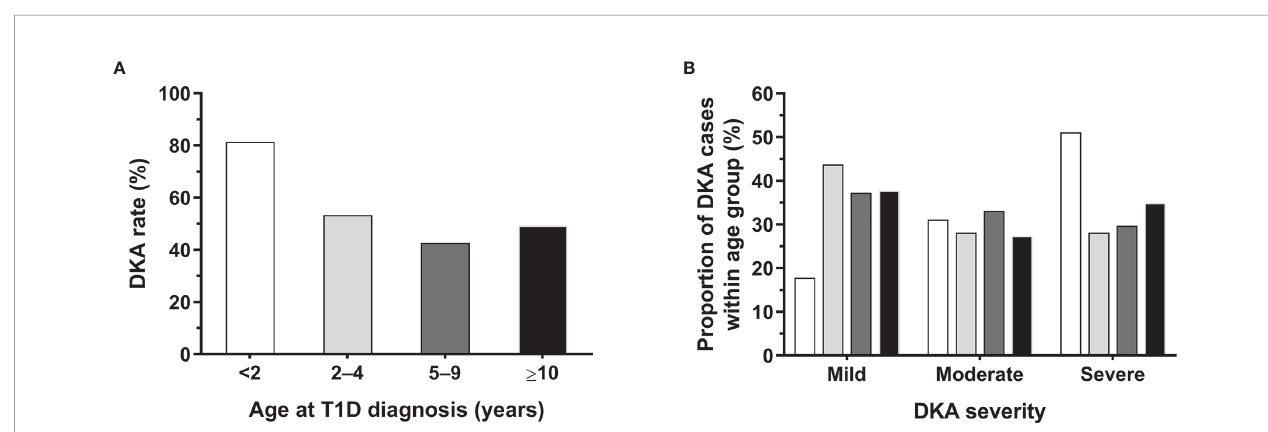
FIGURE 3 | Rates and severity of diabetic ketoacidosis (DKA) among patients aged <16 years newly diagnosed with type 1 diabetes (T1D) at the Children ’ s Hospital of Zhejiang University School of Medicine (Hangzhou, China), according to age group. (A) Percentage of patients with DKA according to age at diagnosis. (B) Proportion of cases according to DKA severity within age group, whose corresponding bars are color coded as per panel (A) ; the number of patients who had DKA at T1D diagnosis and data on its severity in each age group was: <2 years, n=45; 2 – 4 years, n=64; 5 – 9 years, n=118; and ≥ 10 years,